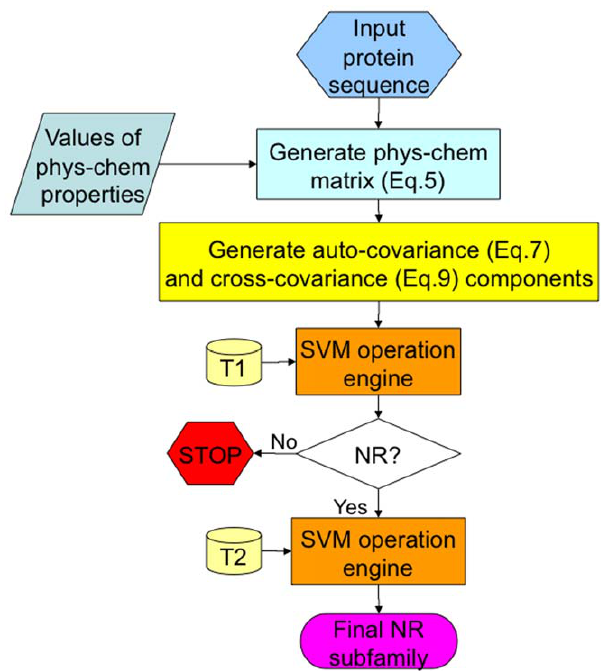
Figure 2. A flowchart to show the prediction process of iNR- PhysChem. T1 represents the benchmark dataset from [16] for training